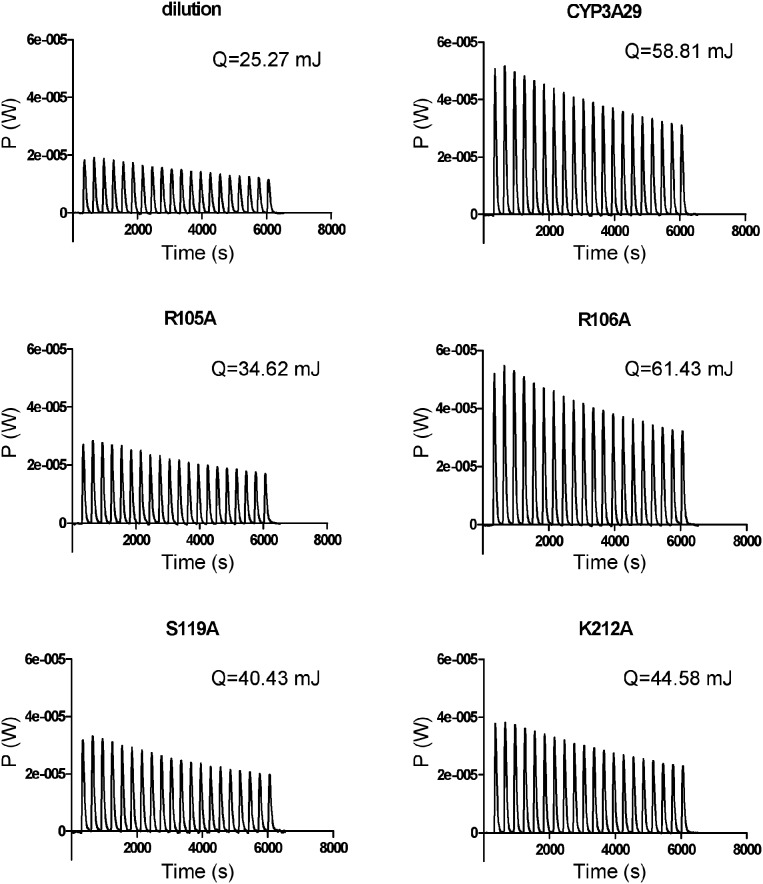
The thermogram of CYP3A29 and its mutants metabolizing T-2 toxin.